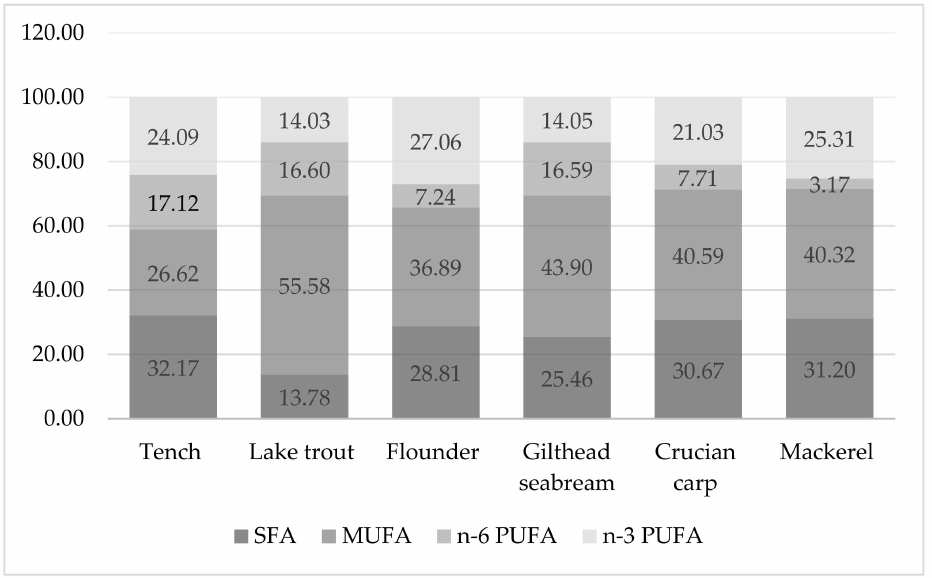
3.3. The Differences between Profile of Fatty Acids (%) and the Lipid Quality Indices in Muscles of Fish Species The saturated fatty acids (SFAs) varied between 13.78% (lake trout) and 32.17% (tench). The muscles of lake trout had statistically significant lower SFAs than other fish species ( p < 0.05) (Figure 1). Palmitic acid (C16:0), which is a long-chain SFA, was the predominant fatty acid in this group as it had sixteen carbon atoms (Table 2).